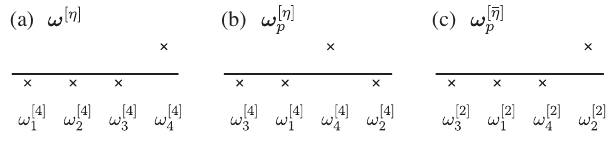
FIG. 3. Complex frequency tuples, for l ¼ 4 , η ¼ 4 , p ¼ ð 3142 Þ , in which case p − 1 ¼ ð 2413 Þ , μ ¼ p − 1 ð η Þ ¼ 3 , ¯ η ¼ p ð η Þ ¼ 2